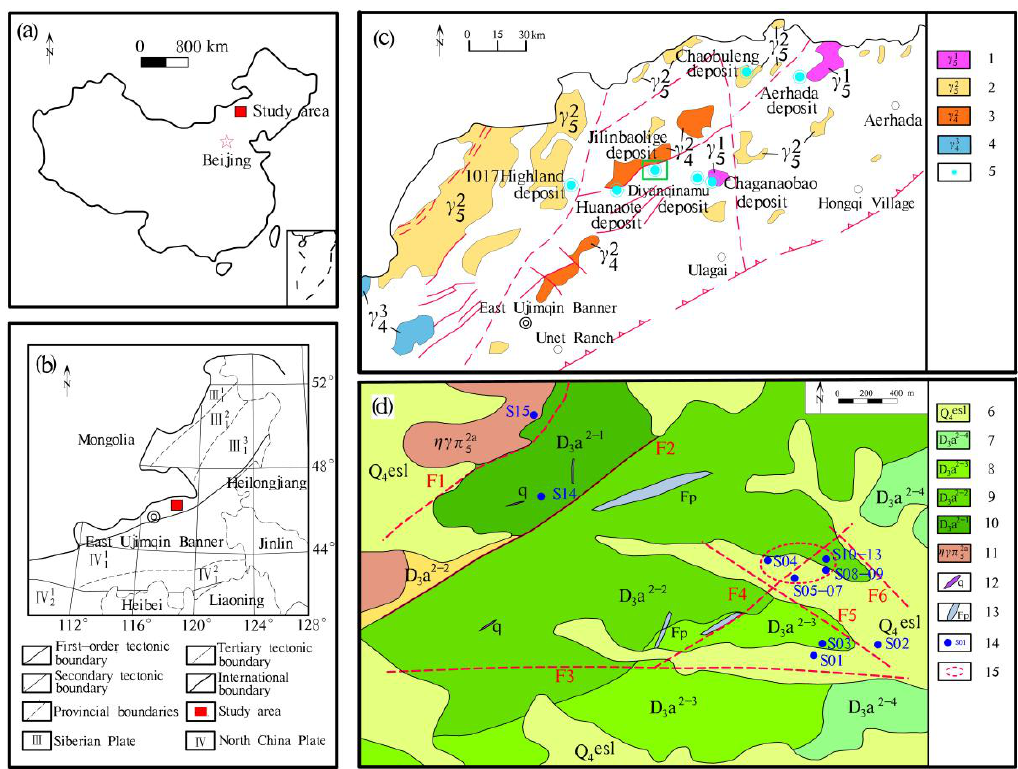
Figure 1. ( a ) Map showing the location of the study area. ( b ) Simplified map showing the structural outline of Inner Mongolia (Huang et al. [25]). ( c ) Geological and mineral map of the middle and southern Great Xing’an Range (Zhang et al. [26]). ( d ) Simplified geologic map of Jilinbaolige (the